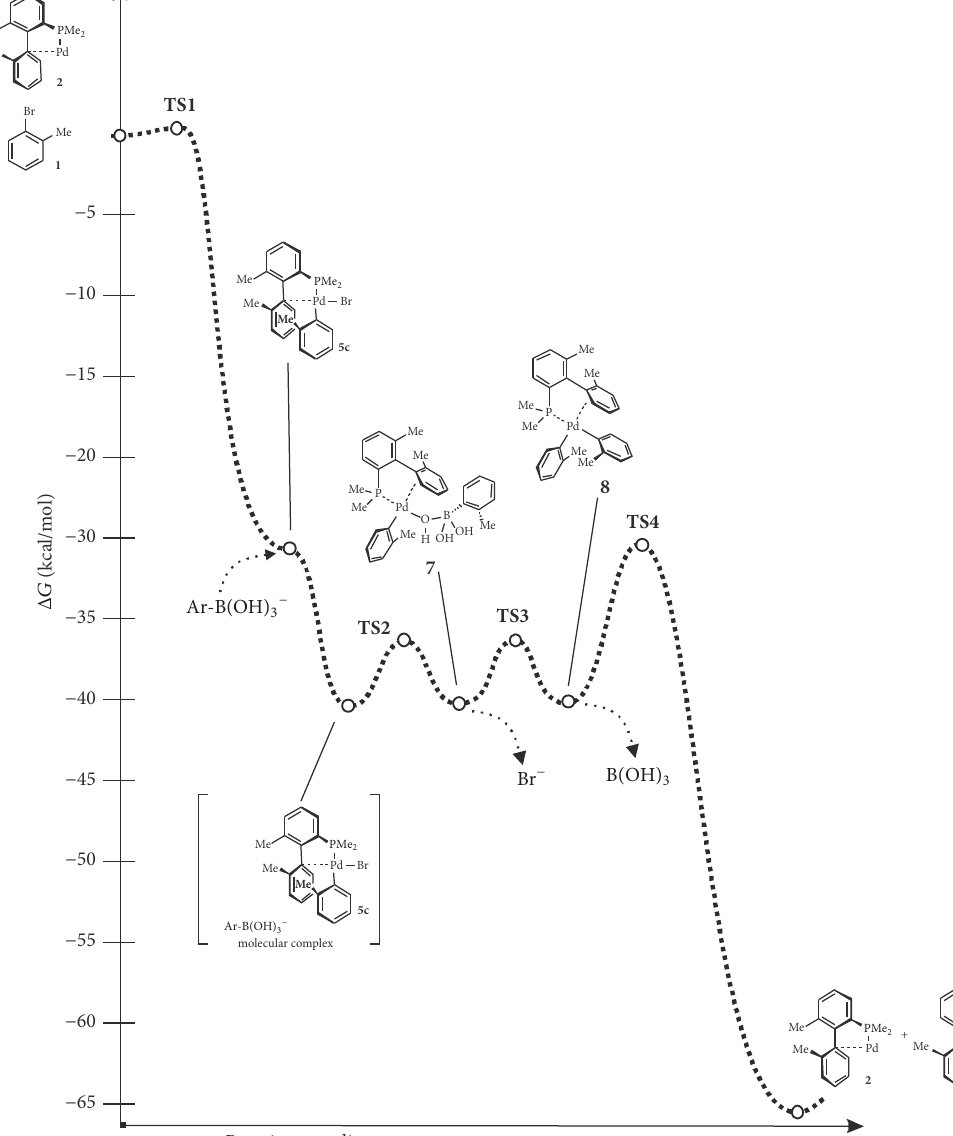
Figure 7: Free Gibbs energy profile for energetically preferred reaction path according to DFT